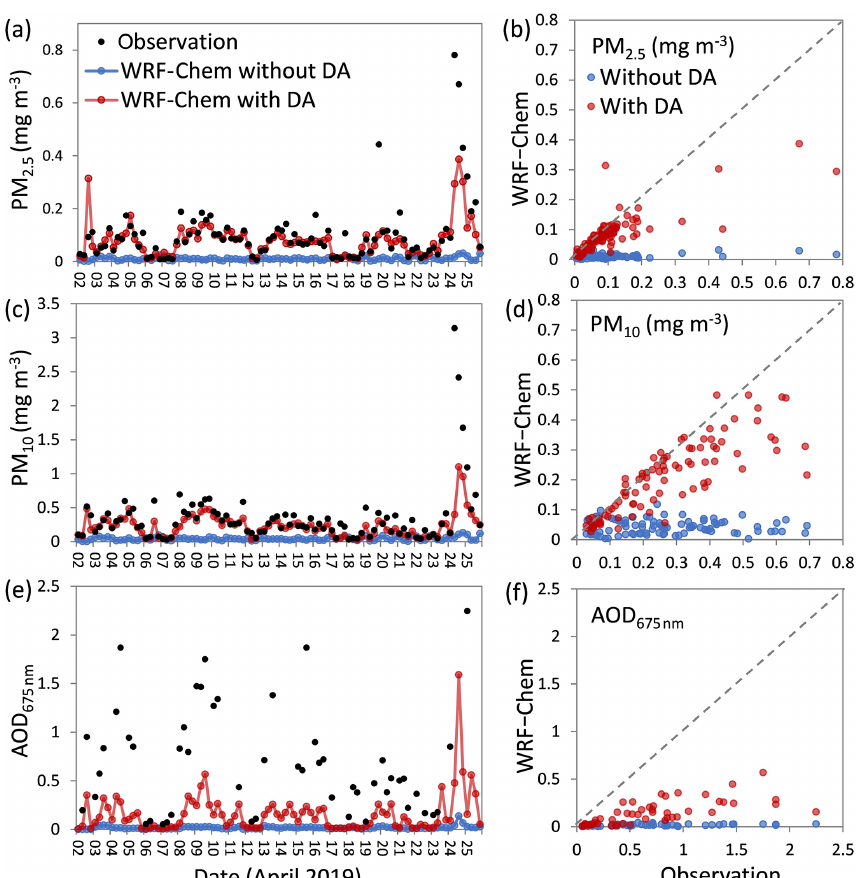
Figure 12. Comparisons of the surface-layer PM 2 . 5 (a, b) and PM 10 (c, d) concentrations and AOD at 675nm (e, f) among the observations, the WRF-Chem simulations with and without data assimilation (DA) in April 2019. The observations have been interpolated to 00:00, 06:00, 12:00, and 18:00UTC of each